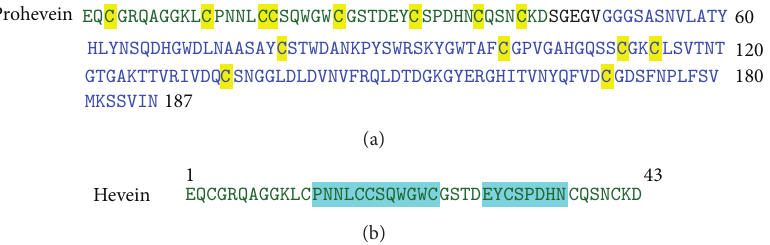
Figure 5: (a) Amino acid sequence of prohevein showing two allergenic domains obtained after posttranslational cleavage: Hev b 6.02 domain (green) and Hev b 6.03 domain (blue). 14 cysteine residues are highlighted in yellow. (b) Amino acid sequence of hevein showing the IgE binding epitopes highlighted in cyan.